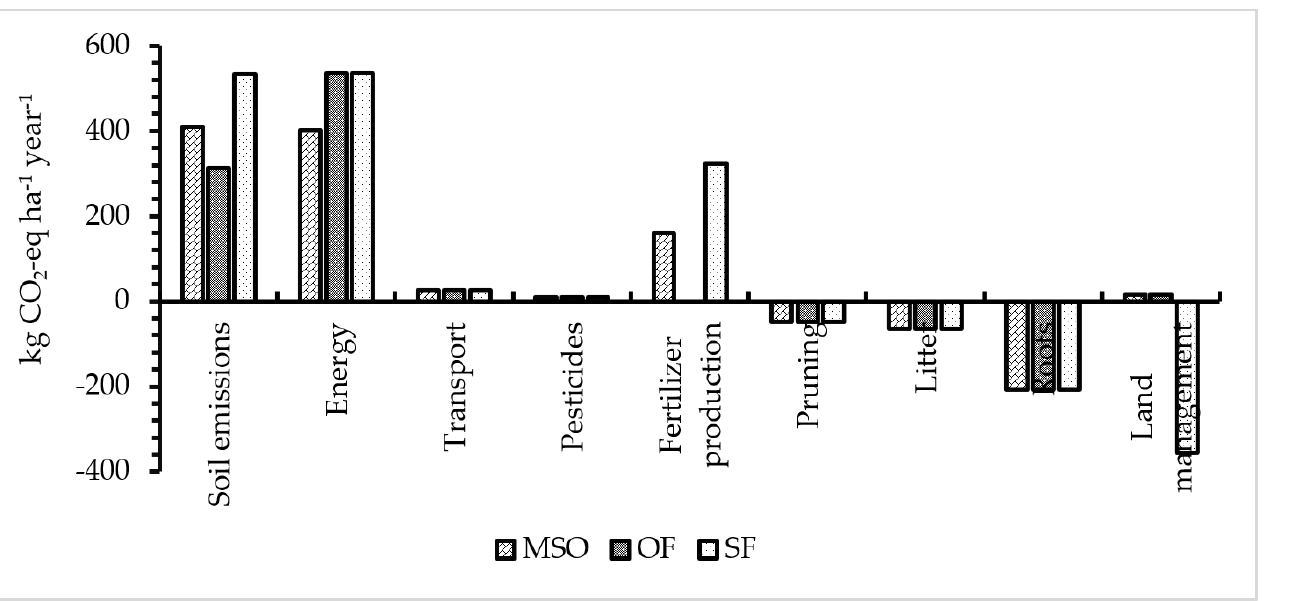
Figure 4. Contribution of parameters and management practices to the CF; data in kg CO 2 -eq ha 1 year −1 . MSO, OF, and SF are the three treatments. Treatment MSO (mix synthetic and organic fertilizer), OF (organic fertilizer), SF (synthetic fertilizer).